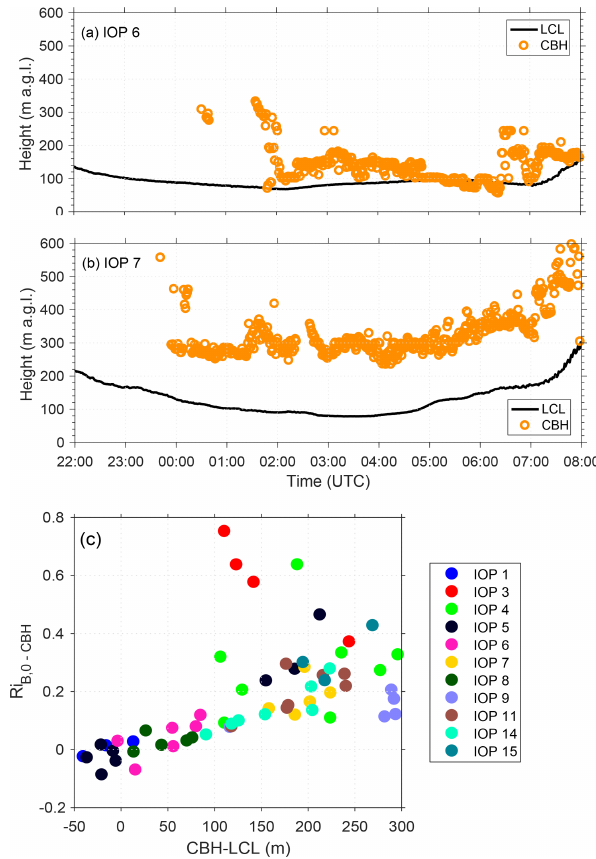
Figure 13. Cloud-base height (CBH) measured by ceilometer and lifting condensation level (LCL) calculated from surface measure- ments at 2ma.g.l. for IOPs 6 (a) and 7 (b) . Relationship between the bulk-Richardson number calculated from radiosoundings for the subcloud layer ( Ri B , 0 − CBH ) and the difference between CBH and LCL (c)